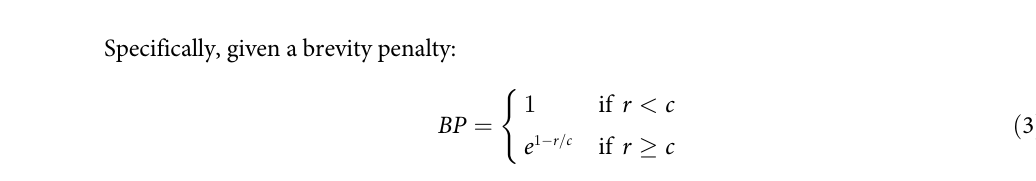
Fig 7. Fluency task: KL distances between distributions of the number of the tokens out of category for different instances of the fluency task. The actual distributions are shown on the right.